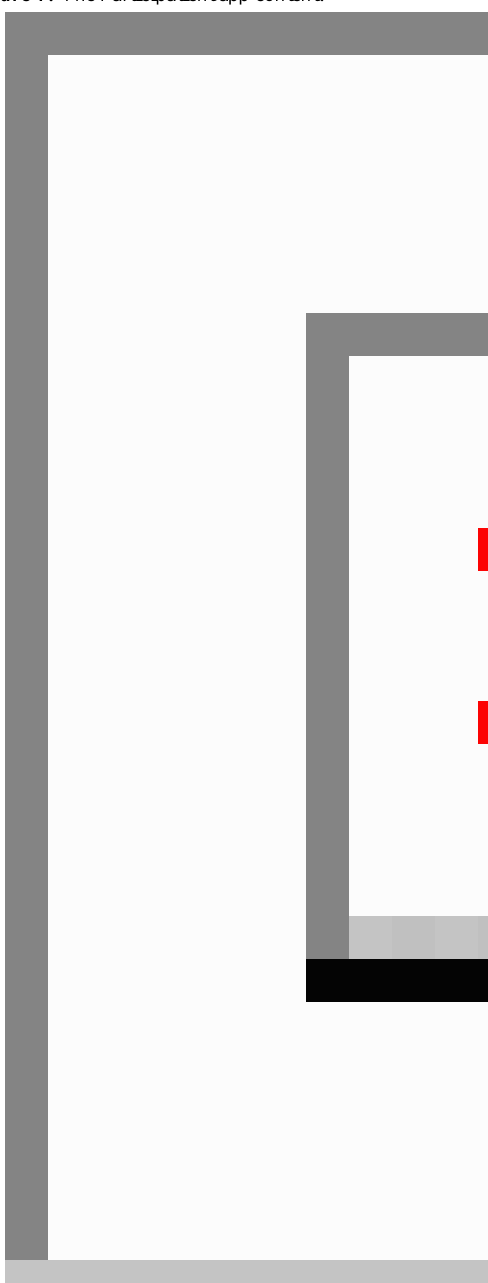
Figure 1. The Participatient app